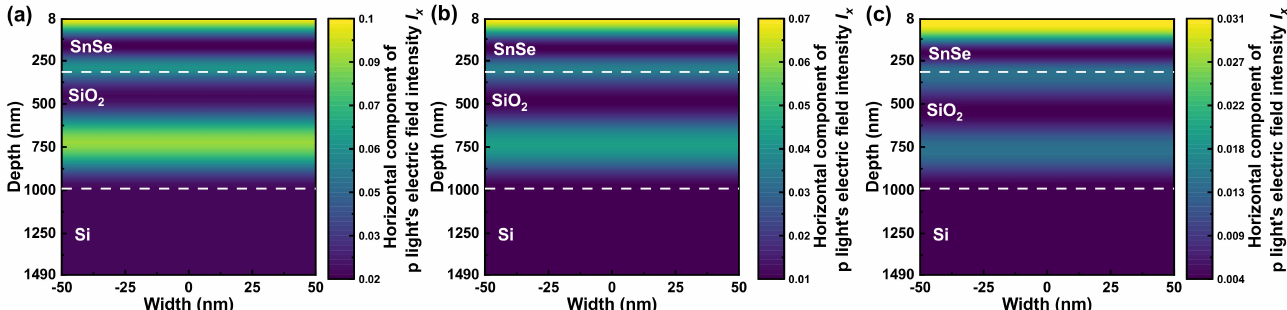
Figure A5. The maximum extinction ratio ER max at the thickness of SiO 2 d SiO with the interval of 25 nm for separating p light at specific wavelength. According to the analysis above, the SiO 2 ’s thickness is selected as 675 nm, and the corresponding SnSe’s thickness is 400 and 315 nm for separating p light over broadband and at specific wavelength respectively.